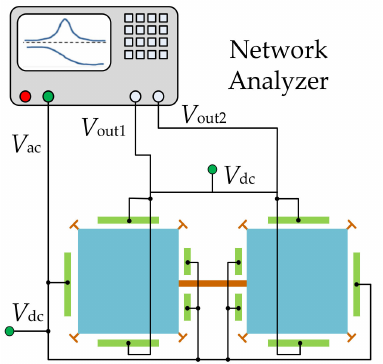
Figure 16. Schematic of a two-port configuration for a 2-DoF square-plate resonator